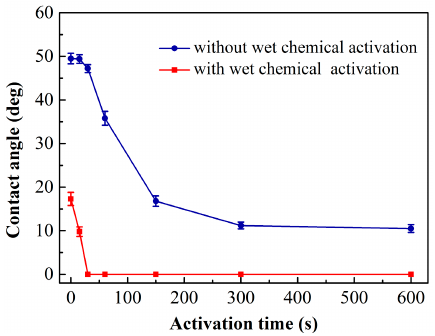
Figure 2. Contact angle as a function of O 2 plasma activation time.